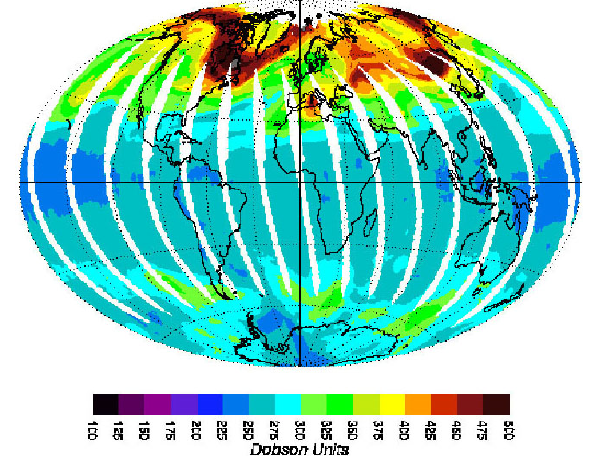
Figure 1. OMI gives full daily coverage except for stripes of data loss due to the row anomaly error beginning in